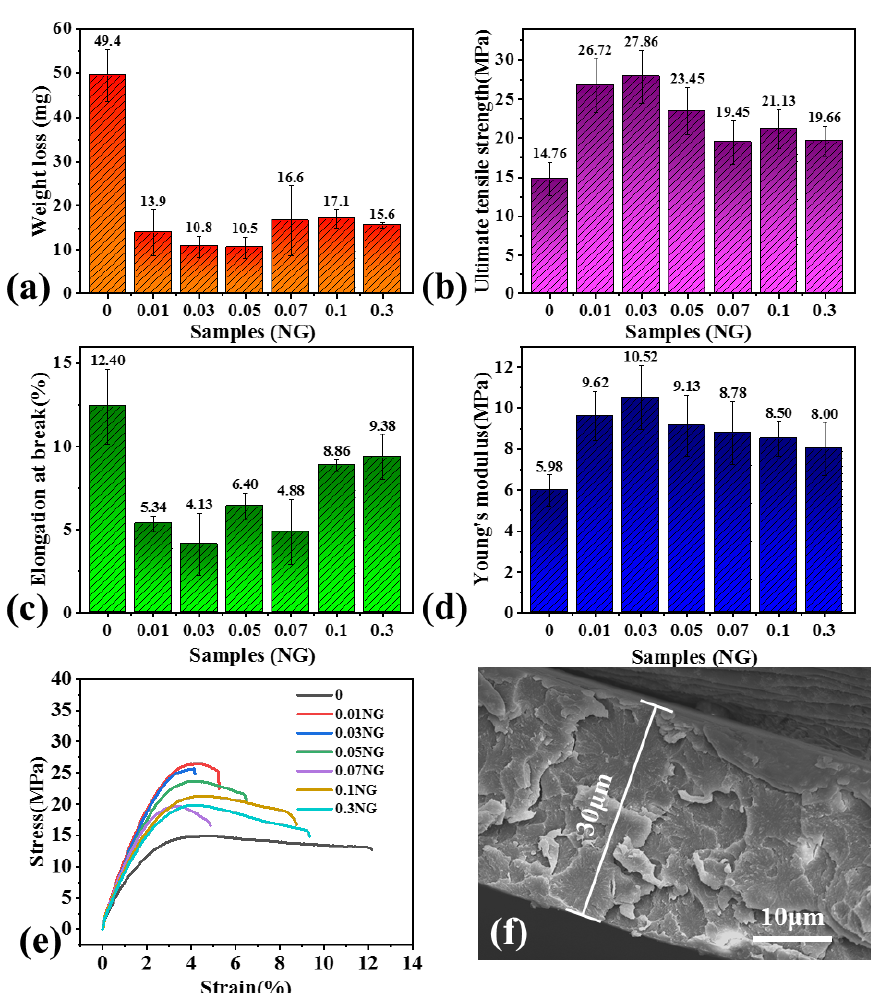
Figure 4. Mechanical tests of the samples with different NGS content: ( a ) weight loss from Taber test, ( b ) ultimate tensile strength, ( c ) elongation at break, ( d ) Young’s Modulus, ( e ) representative stress-strain curves (details of five samples of different content is shown in Figure S2), ( f ) cross-section of specimens underwent tensile break.